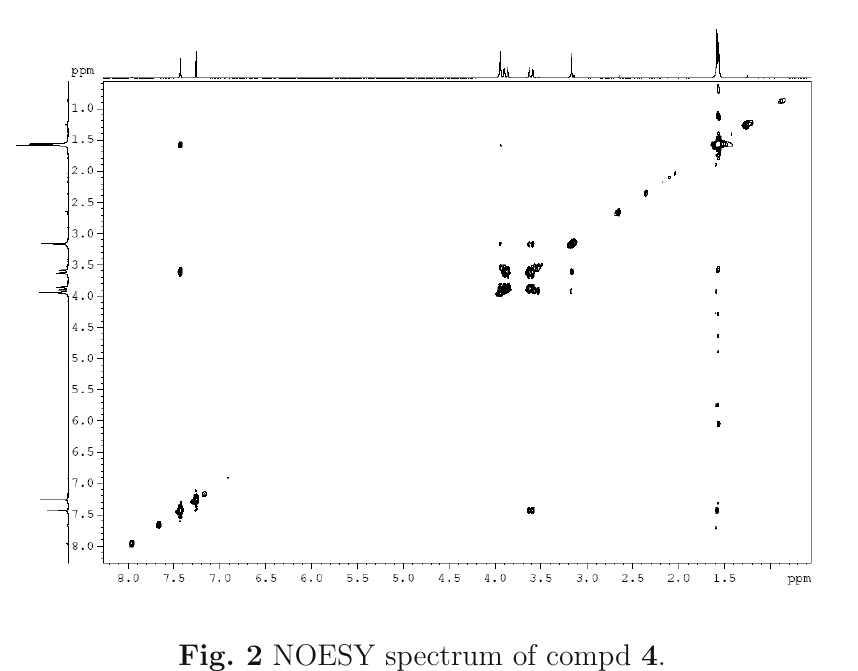
Fig. 2 NOESY spectrum of compd 4